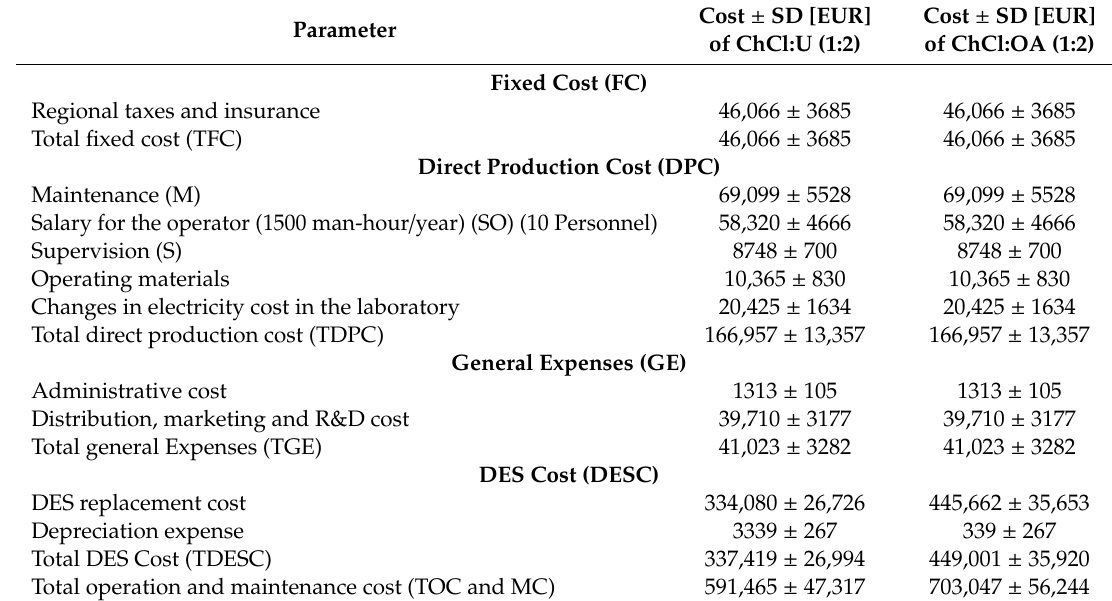
Table 8. General estimate of the operation cost (OC) and maintenance cost (MC) for